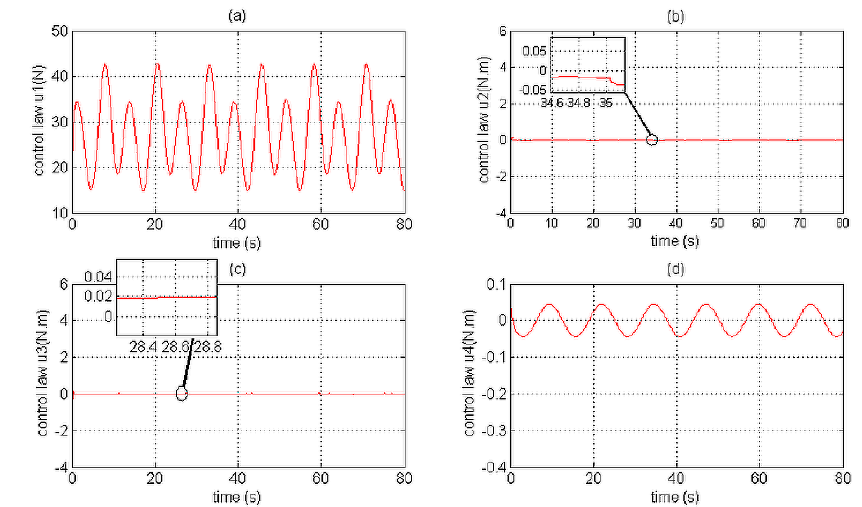
Figure 27. The applied control laws of the PTCM: ( a ) control law u 1 (N); ( b ) control law u 2 (N · m); ( c ) control law u 3 (N · m); ( d ) control law u 4 (N · m).